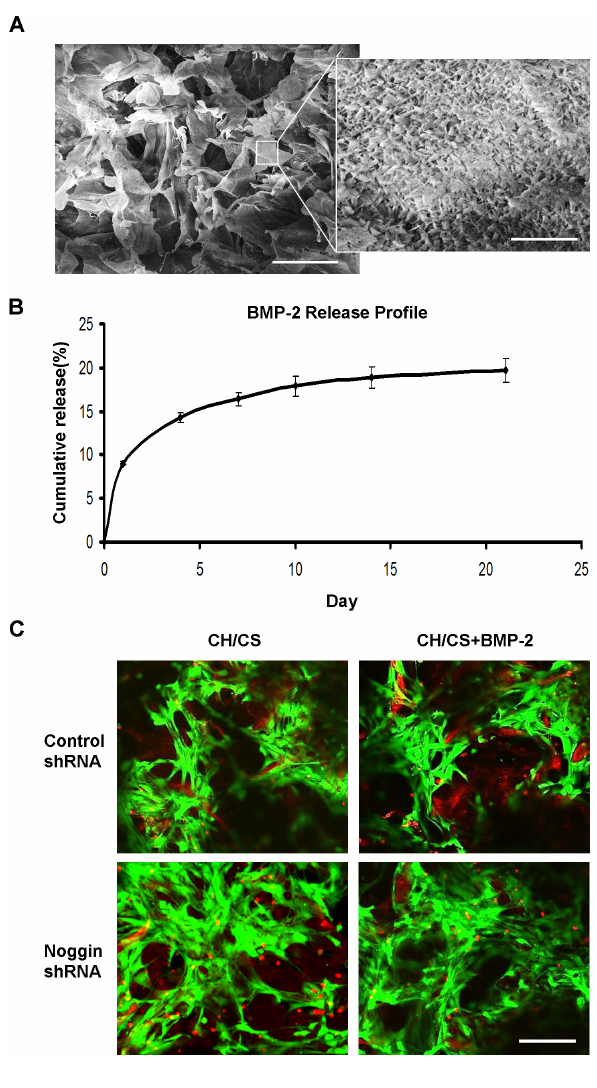
Figure 5. (A) SEM images of apatite-coated CH/CS scaffolds. Scale bar = 200 m m; scale bar of the inset image = 20 m m. (B) In vitro release of BMP-2 from CH/CS scaffolds. (C) Live-dead fluorescent staining of ASCs seeded on CH/CS scaffolds after 14 days in culture. Scale bar = 200 m m. doi:10.1371/journal.pone.0072474.g005 shRNA treated ASCs had a similar viability of 91.6 6 0.6% and 92.8 6 1.1%.